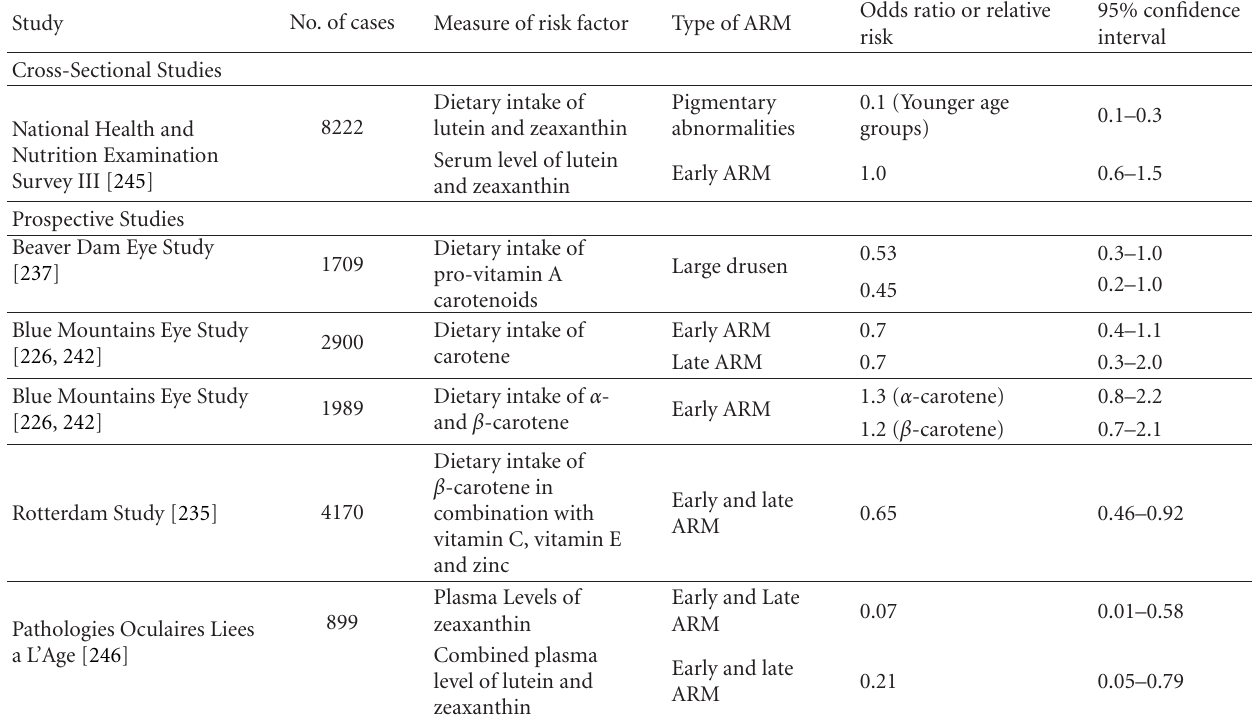
Table 12: Studies investigating the relationship between dietary and serum levels of carotenoids and risk for